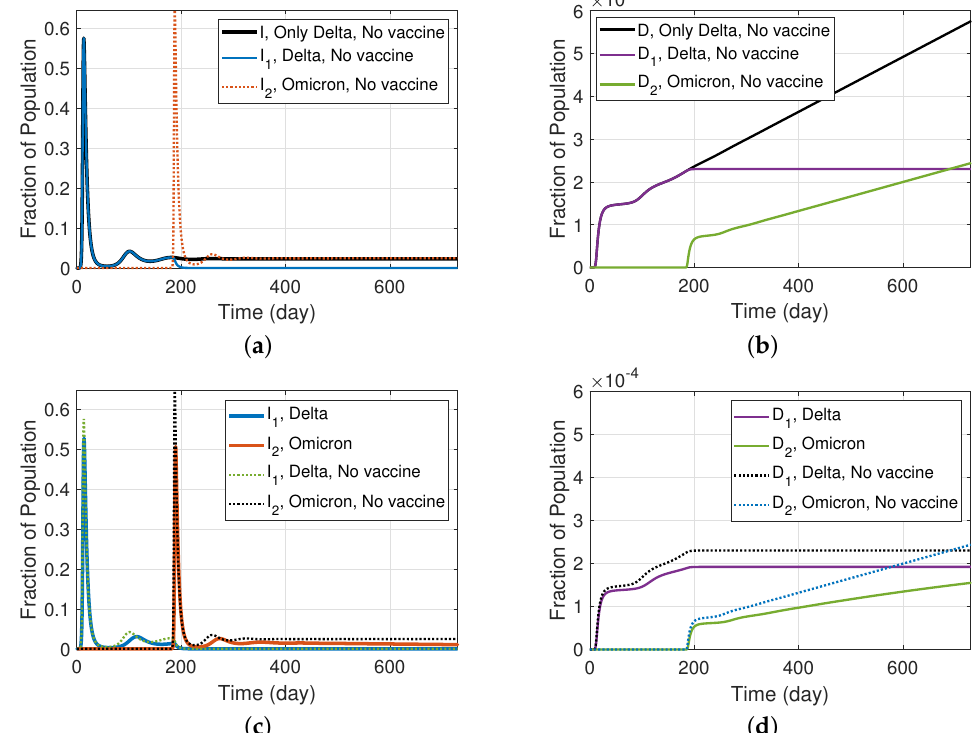
Figure 15. Results for an SIRS model with two variants and a vaccine with different efficacy (model depicted in Figure 14); ( a ) fraction of infectious population and ( b ) fraction of deceased population, when Omicron appears half-way through Delta, in comparison with a case with only delta. ( c ) Fraction of infectious population and ( d ) fraction of deceased population, when Omicron appears half-way through Delta, assuming that a vaccine with different effectiveness on Delta and Omicron is available from the beginning, and the vaccination rate is